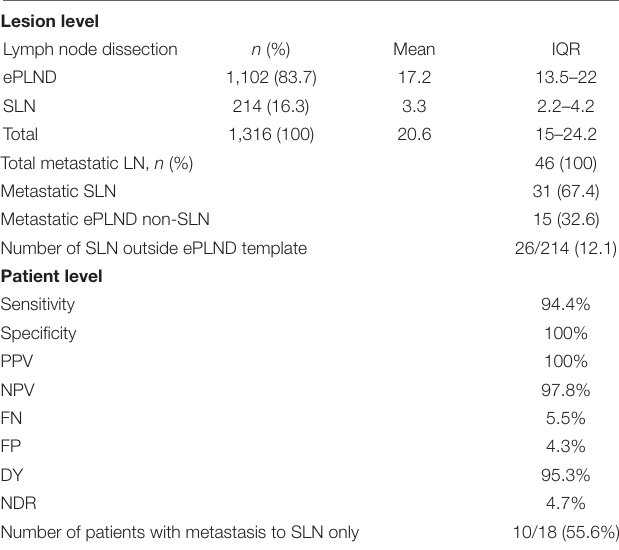
TABLE 3 | Sentinel lymph nodes and extended pelvic lymph node dissection findings.